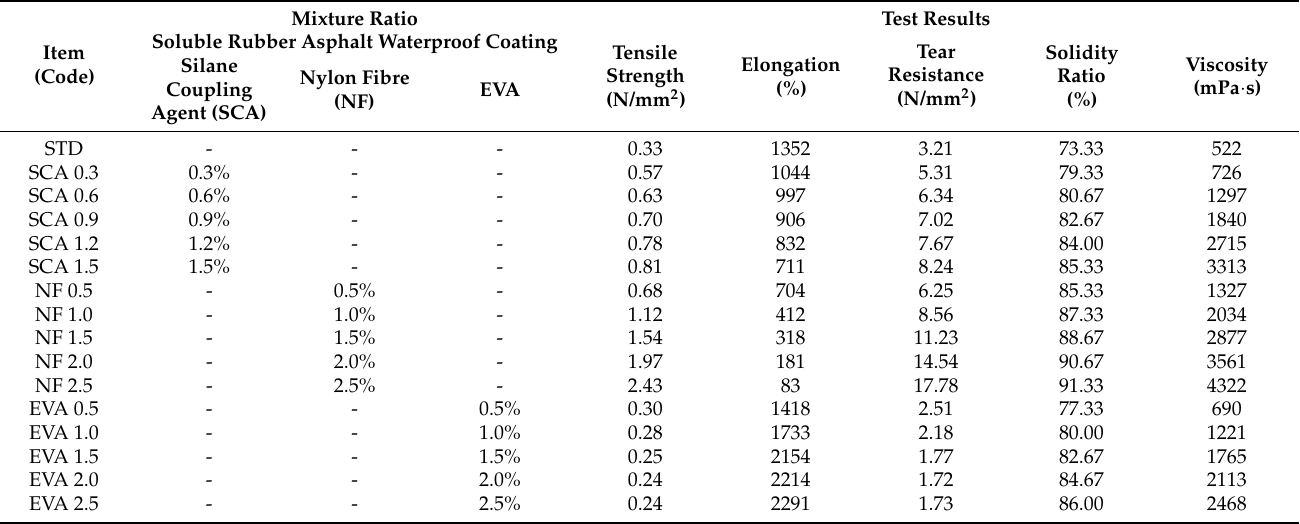
Table 6. The physical properties of water-soluble rubber-asphalt-based waterproofing materials according to the type and content of